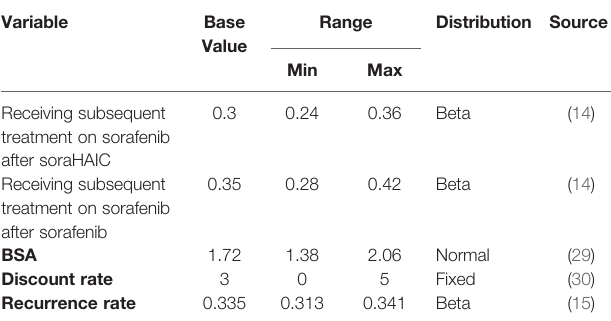
TABLE 2 | Base parameters input to model and ranges of sensitivity